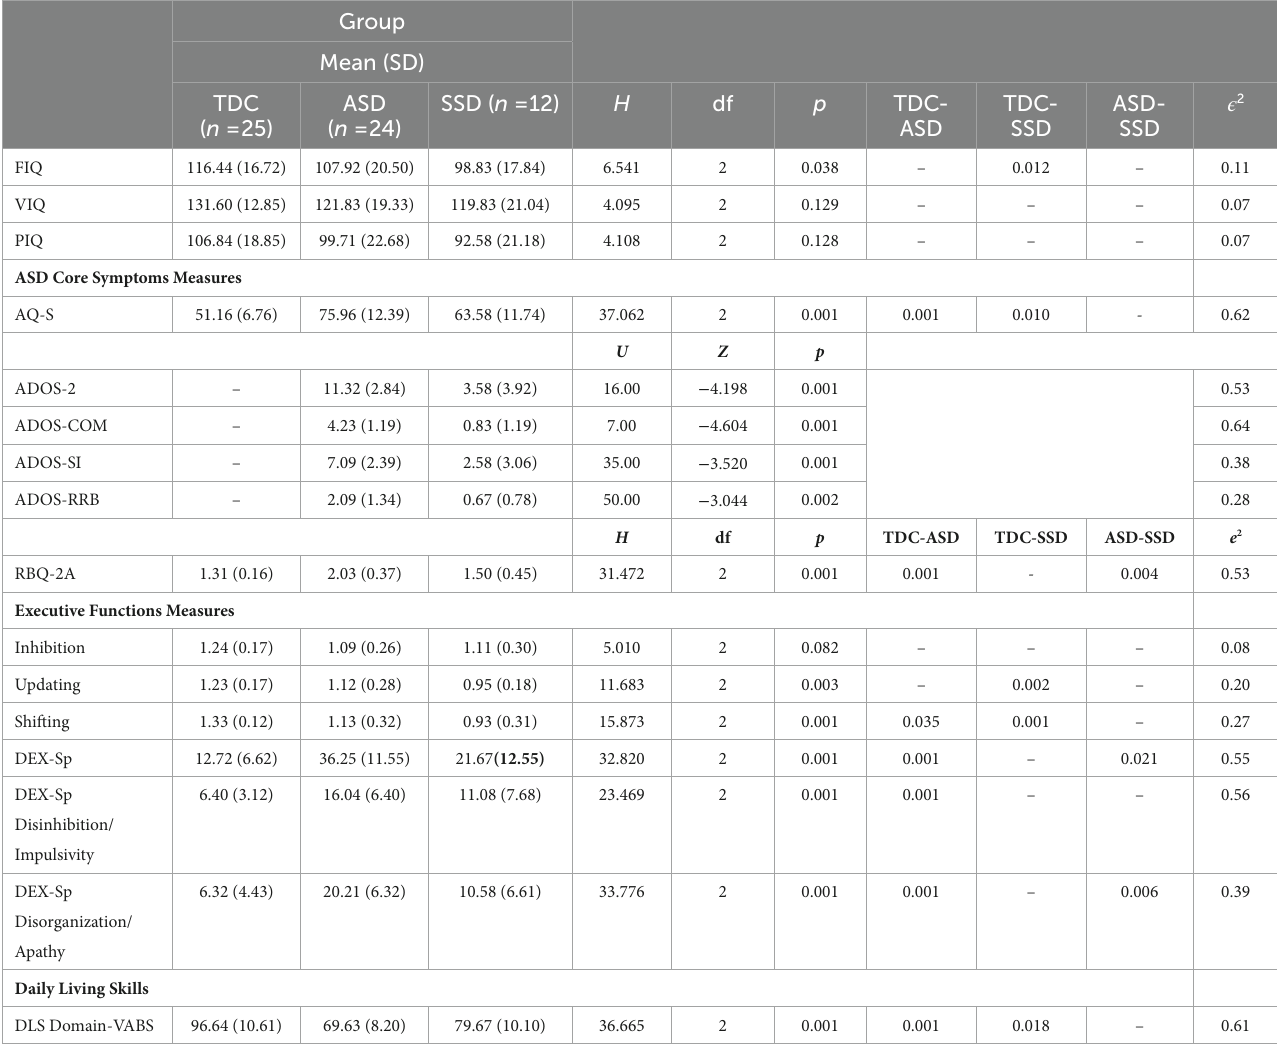
TABLE 2 Group differences on IQ, EFs and ASD core symptoms.